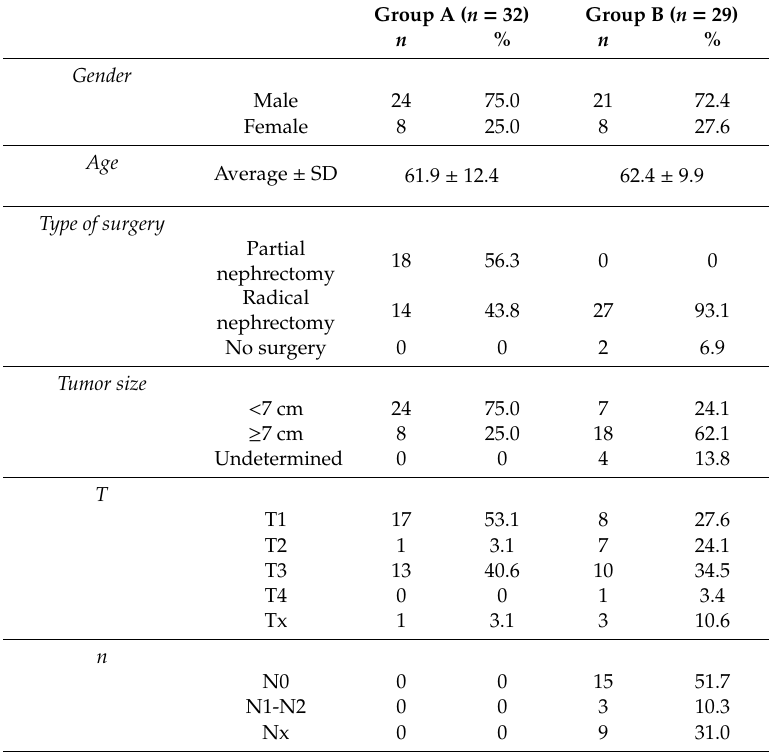
Table 3. Clinical-pathological characteristics of the study population. Group A consists of patients with localized disease and Group B consists of patients with metastatic